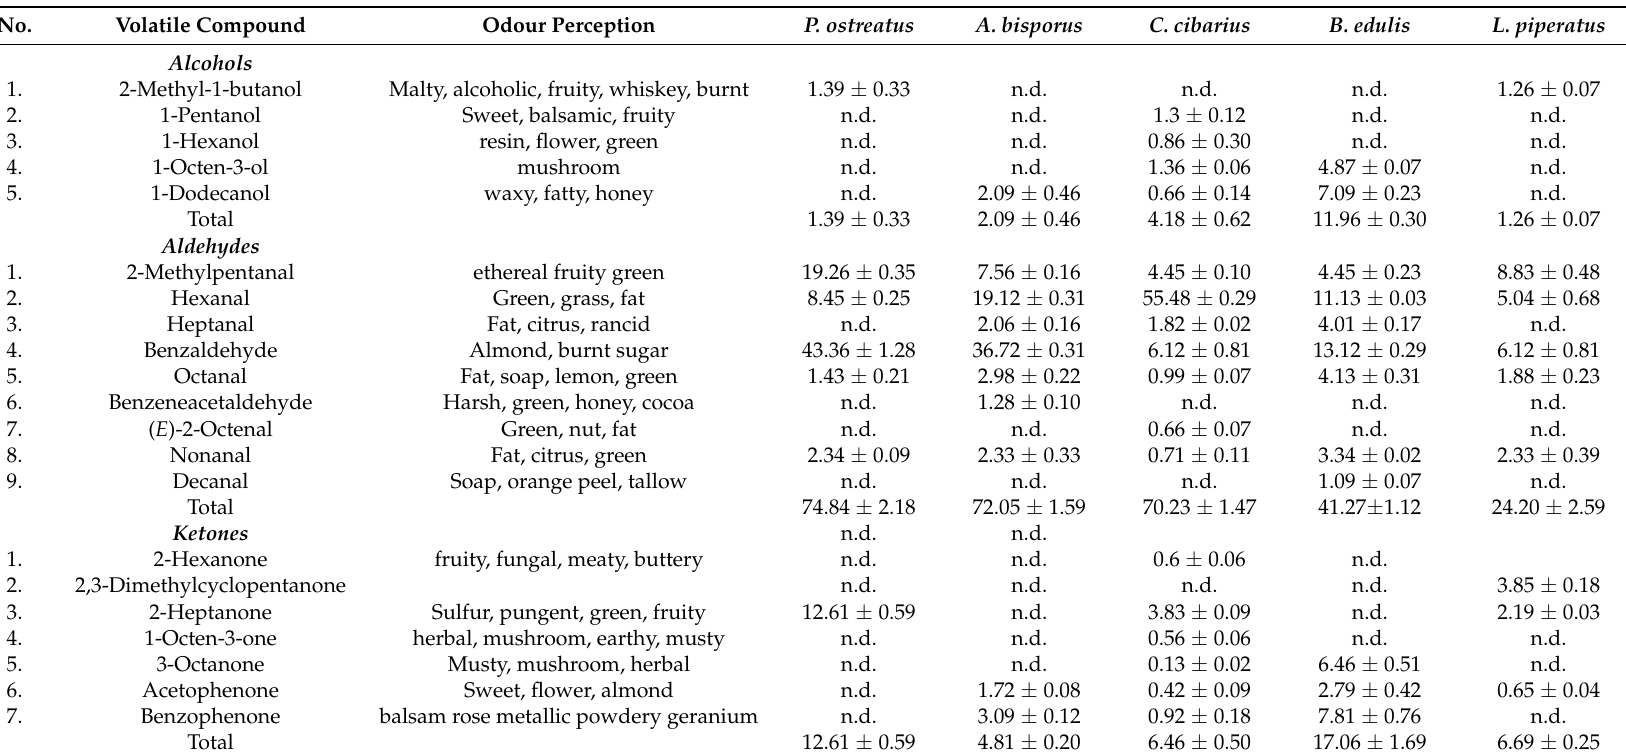
Table 3. Mean relative peak areas (expressed as % from total peak areas) and standard deviations of volatile compounds from mushroom samples analysed by HS-ITEX/GC-MS